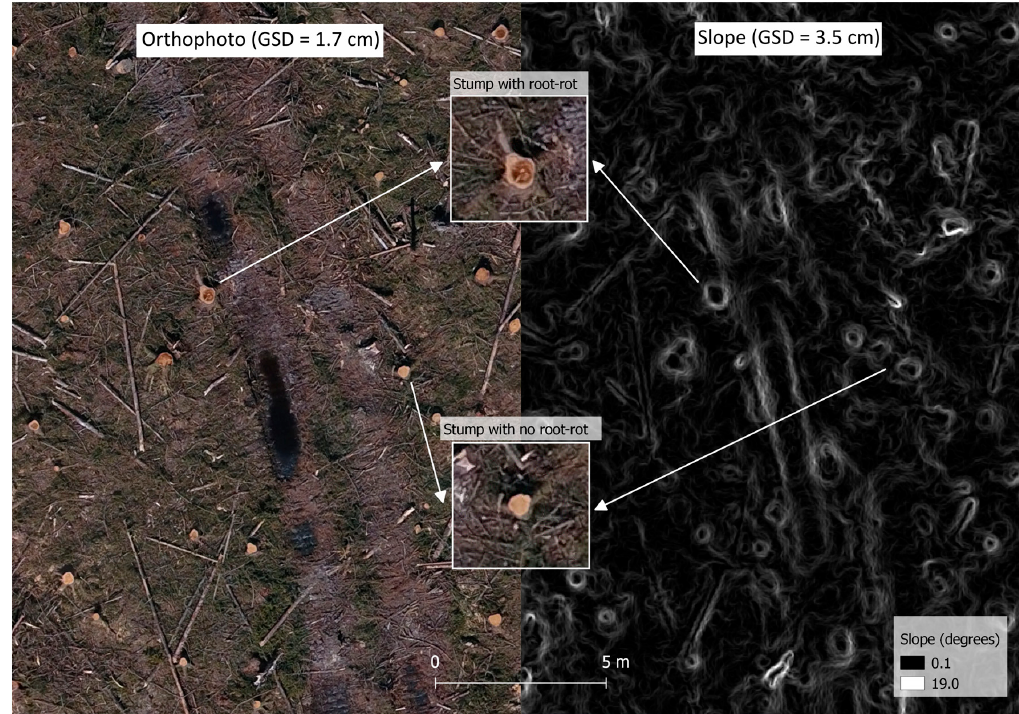
Figure 4. Overview of the UAV data used for the purpose of this study: on the left the orthophoto with ground sampling distance (GSD) of 1.7 cm, and on the right the slope raster of GSD = 3.5 cm that was derived from the digital surface model. The slope raster is included exclusively for visualization purposes as it clearly shows the shape of the tree-stumps.